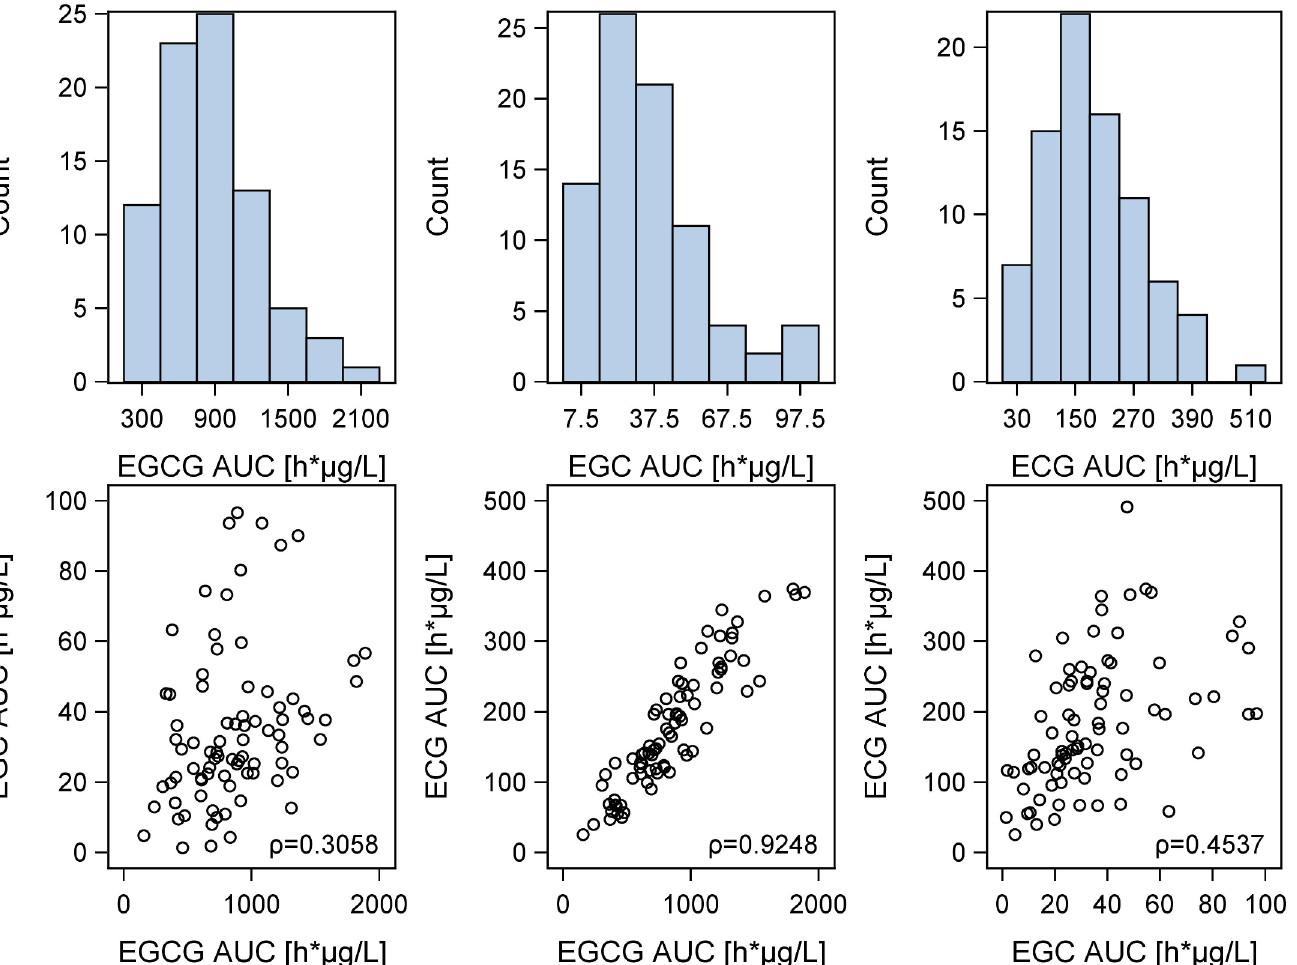
Fig 4. Correlation between the AUCs of the different green tea catechins. Distribution histograms of the AUCs and scatter plots showing the correlation between the AUCs of the different green tea catechins. ρ: Pearson correlation coefficients: AUC EGCG −AUC EGC : 0.3058 (p = 0.0052); AUC EGCG −AUC ECG : 0.9248 (p < 0.0001), AUC EGC −AUC ECG : 0.4537 (p < 0.0001).